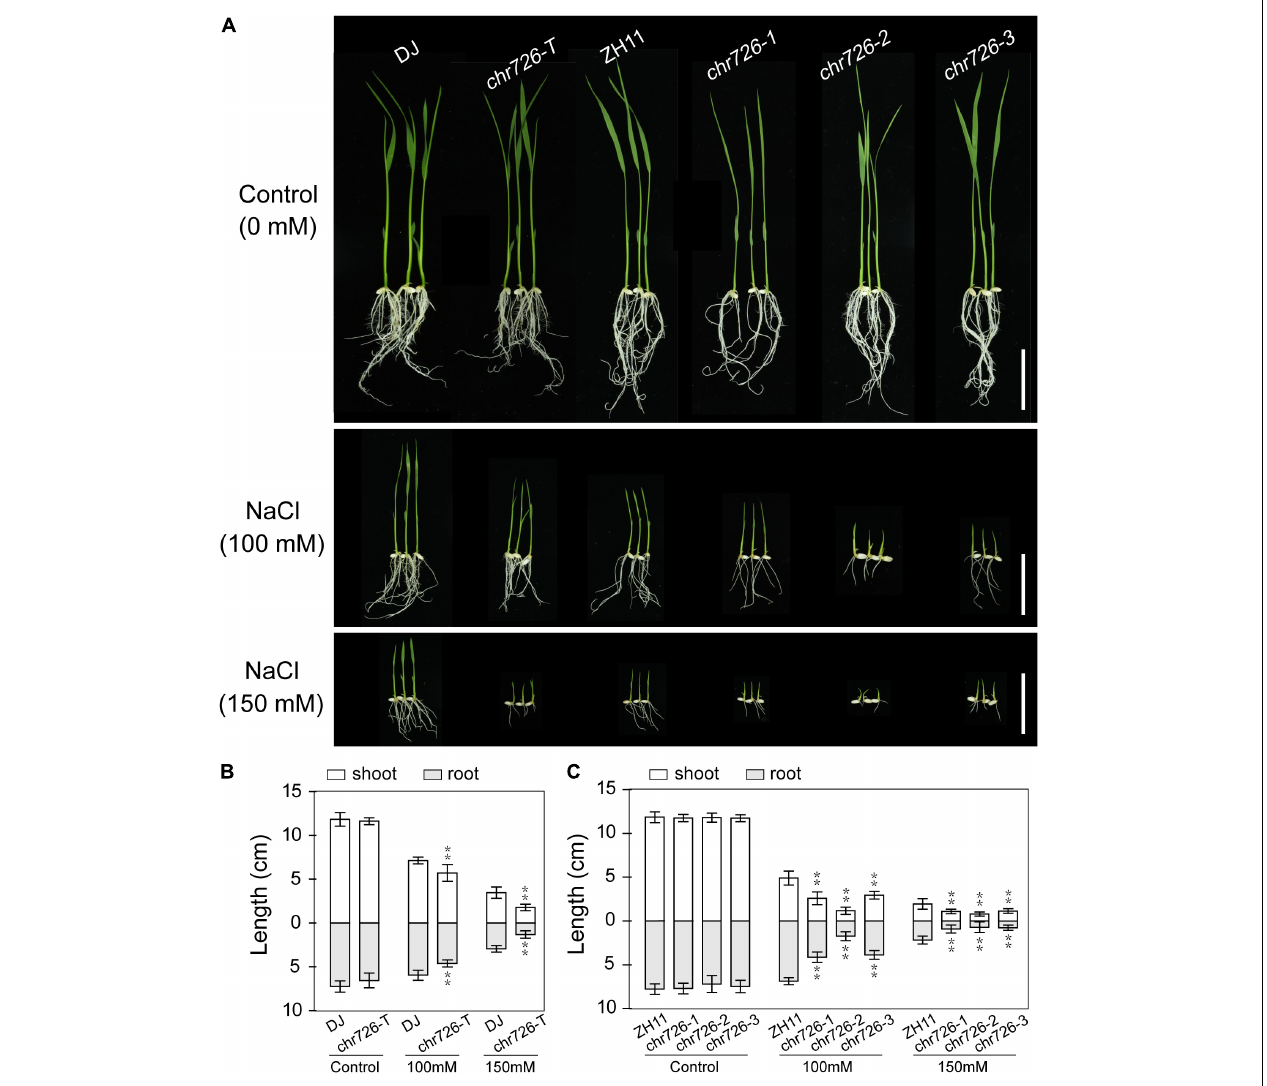
FIGURE 9 | oschr726 is sensitive to salt stress treatment. (A) The performance of oschr726 seedlings compared with WT on media containing 0, 100, 150 mM NaCl. Bar = 5 cm. (B) The shoot and root lengths of 7-day-old seedlings were analyzed on WT (DJ) and T-DNA mutant. (C) The shoot and root lengths of 7-day-old seedlings were analyzed on WT (ZH11) and CRISPR/Cas9-mediated mutations. n = 20, Two asterisks (** p < 0.01, Student’s t -test) represent significant differences between the wild-type and